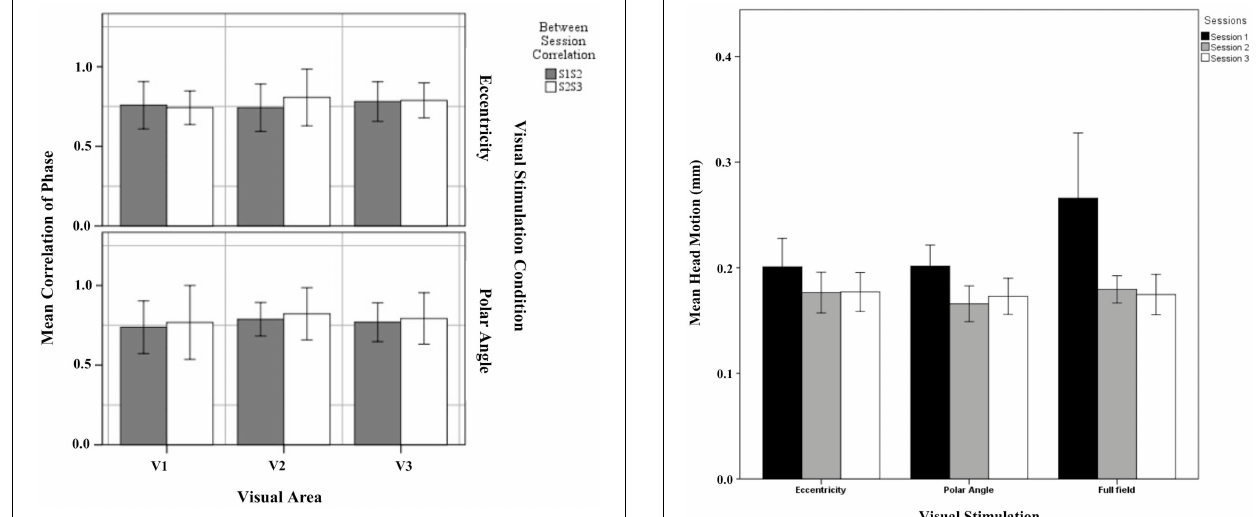
FIGURE 6 | Quantitative comparison (mean ± SEM) of head movement across sessions for all visual stimulation conditions. No significant effects were observed as detailed in